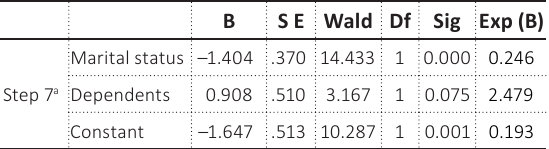
Table 10. Backward stepwise